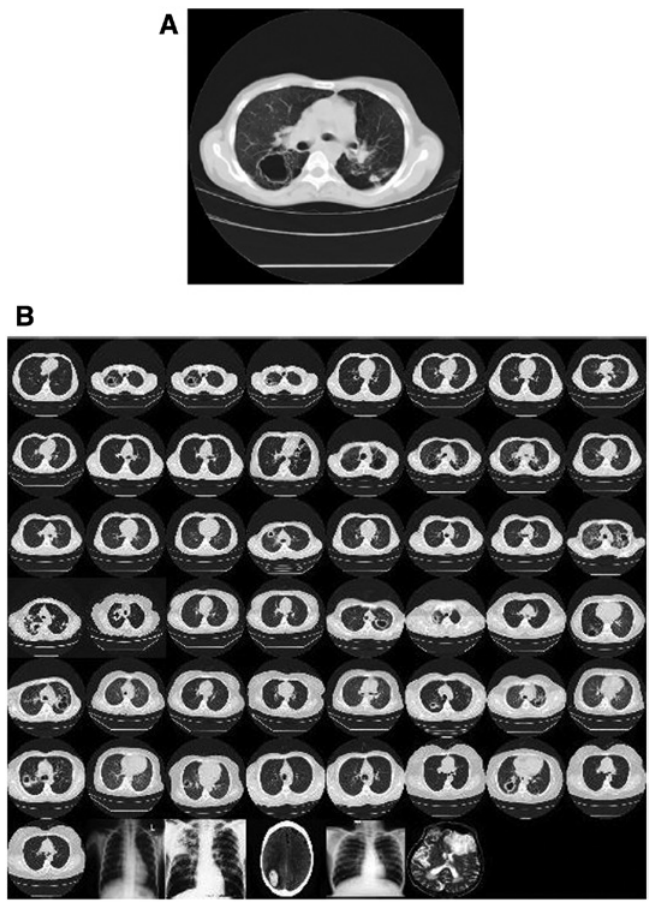
Figure 4: Sample Output Obtained in the Retrieval Process for Lung Image. (A) Query image; (B) retrieved